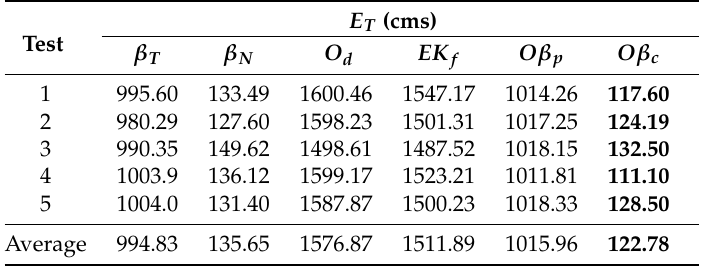
Table 6. Localization error for Trajectory 3. The least error for each row is written in bold.